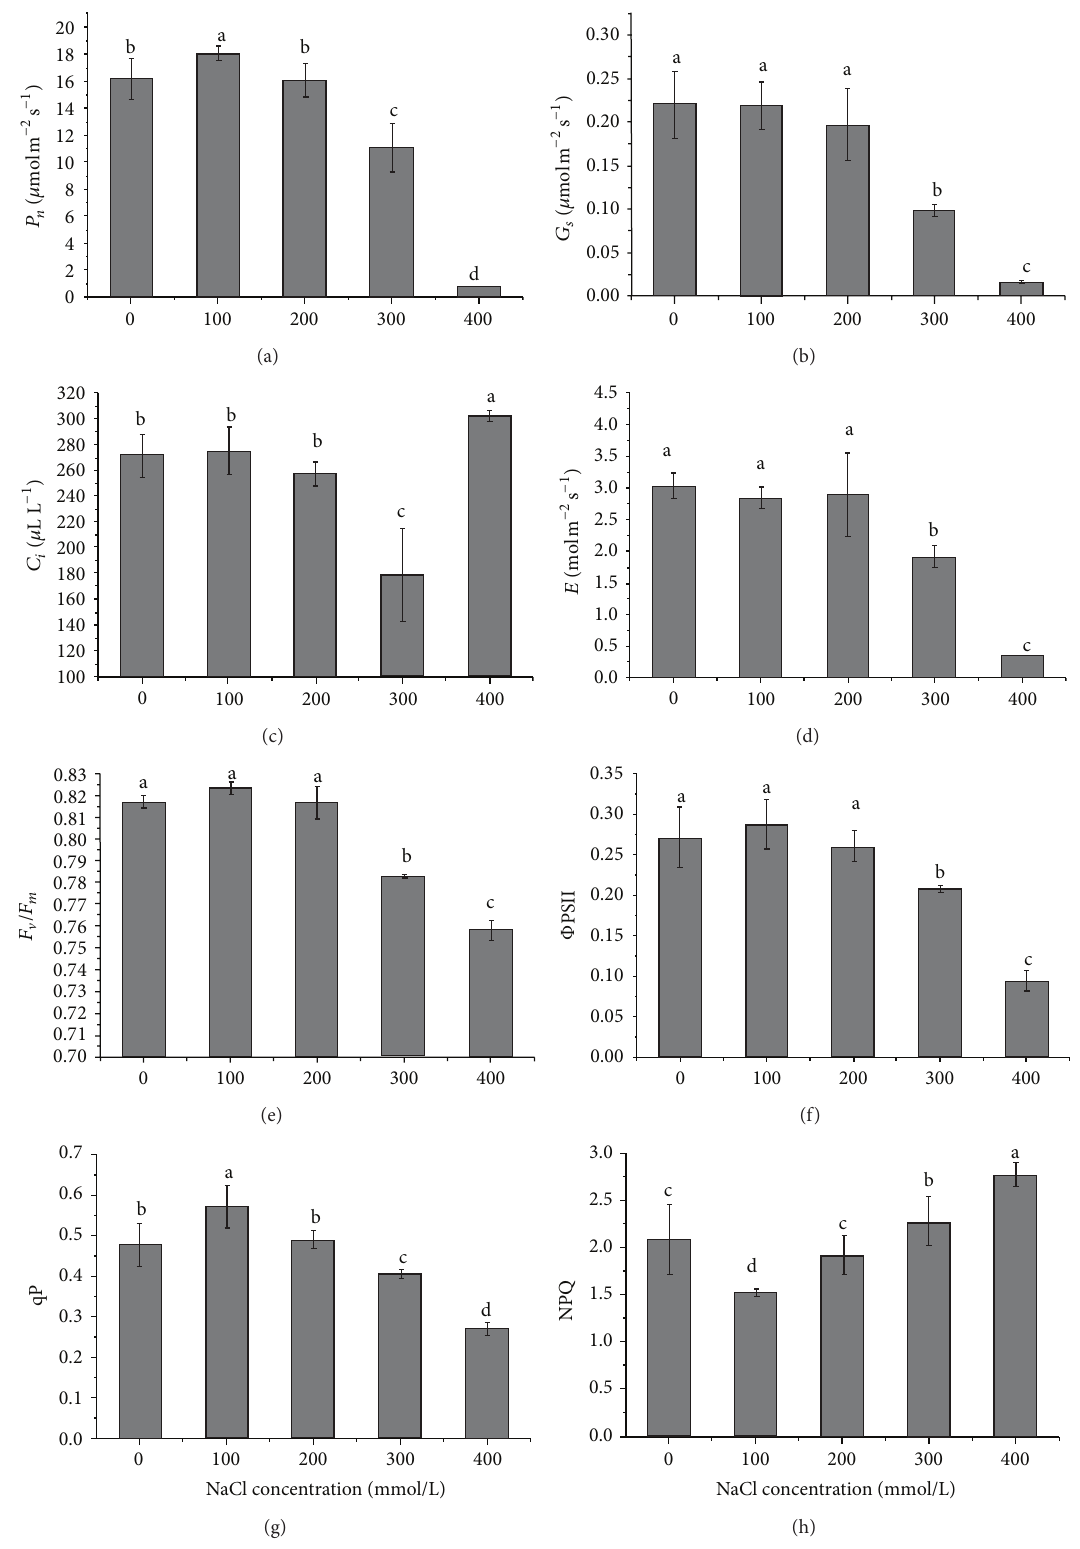
Figure 2: Changes of net photosynthetic rate ( 𝑃 𝑛 , (a)), stomatal conductance ( 𝐺 𝑠 , (b)), intercellular CO 2 concentration ( 𝐶 𝑖 , (c)), transpiration rate ( 𝐸 , (d)), maximal photochemical efficiency of PSII ( 𝐹 V / 𝐹 𝑚 , (e)), actual photochemical efficiency of PSII ( Φ PSII, (f)), proportion of open PSII (qP, (g)), and nonphotochemical quenching (NPQ, (h)) in seedlings exposed to different NaCl